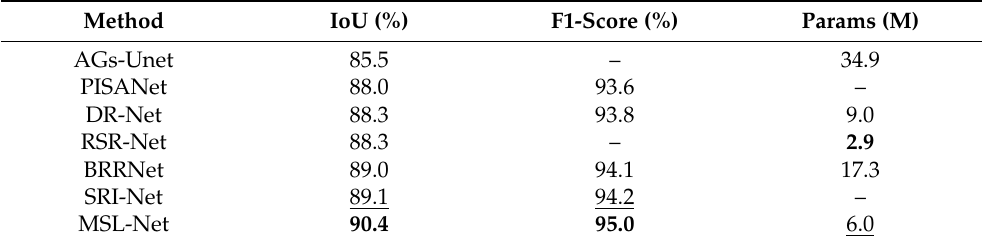
Table 8. Comparison with state-of-the-art methods on the WHU dataset. Here, ‘–’ denotes that the paper did not provide relevant data. The best results are bolded; the second-best results are